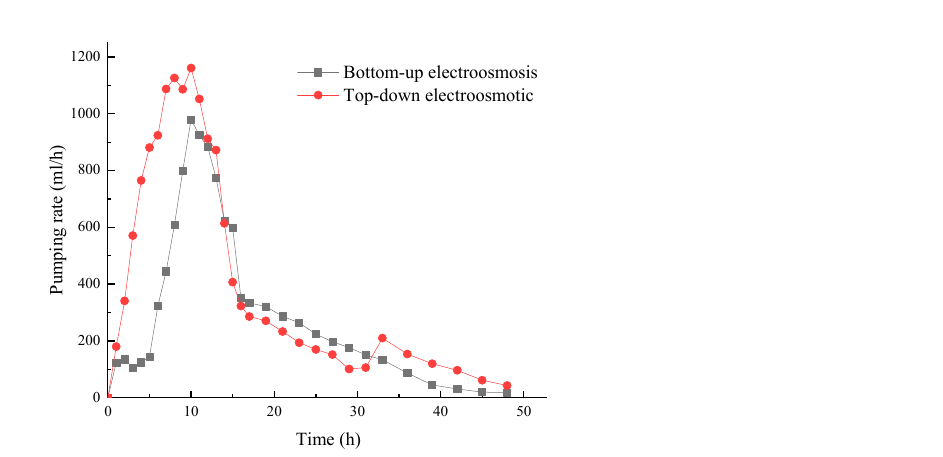
Figure 10. Variation curve of water discharge rate with time in electro-osmosis test.